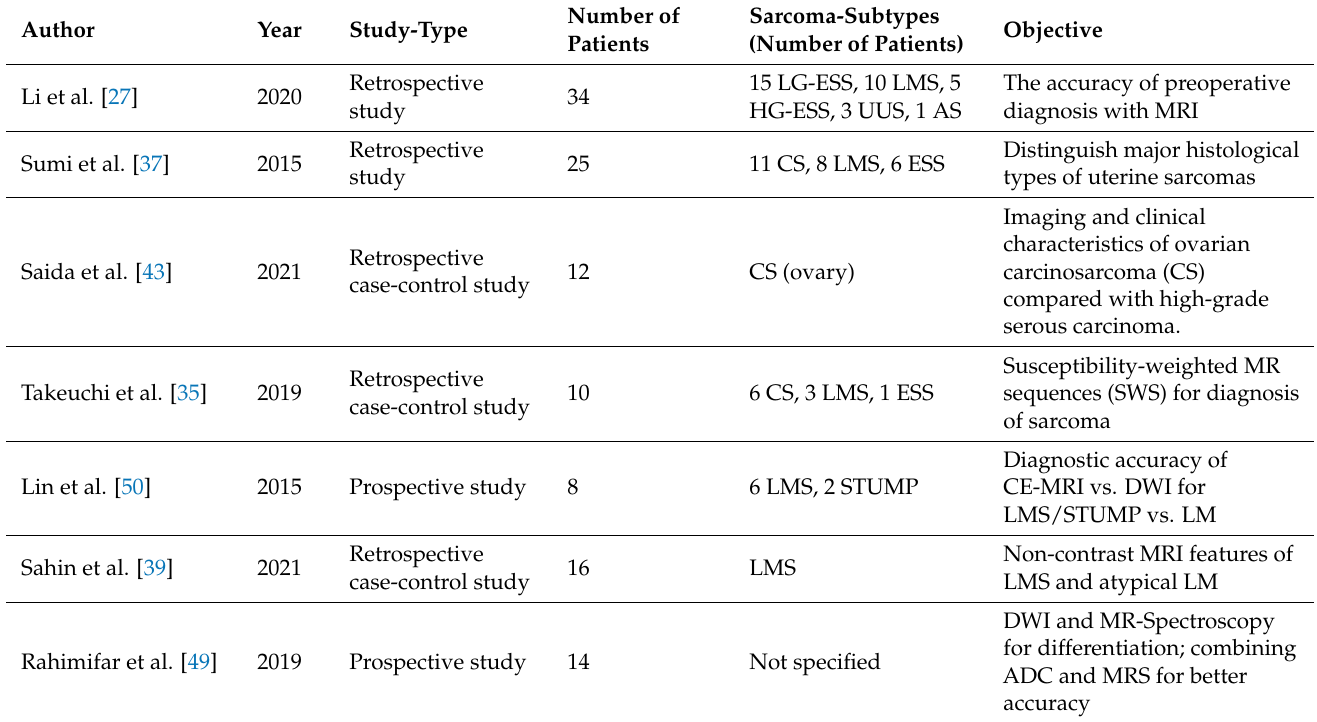
Table 2. Overview of reviewed studies on